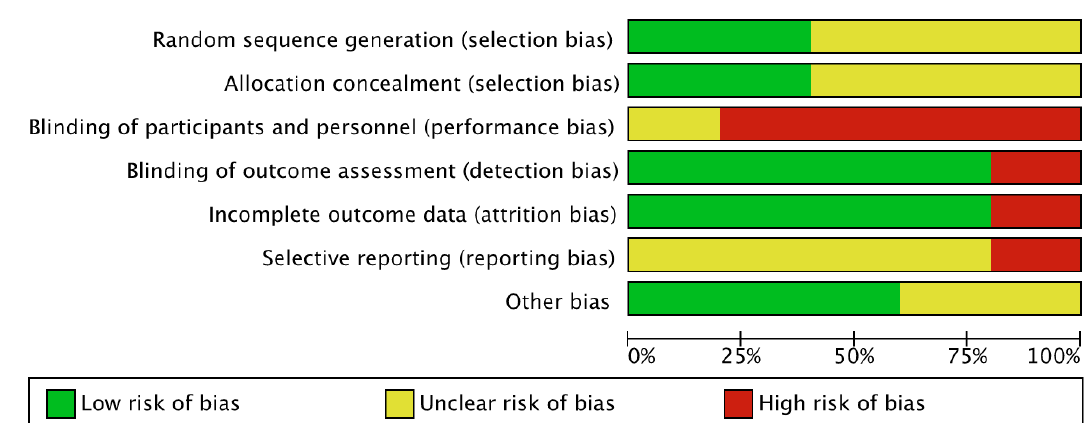
Figure 3. Risk of bias graph.